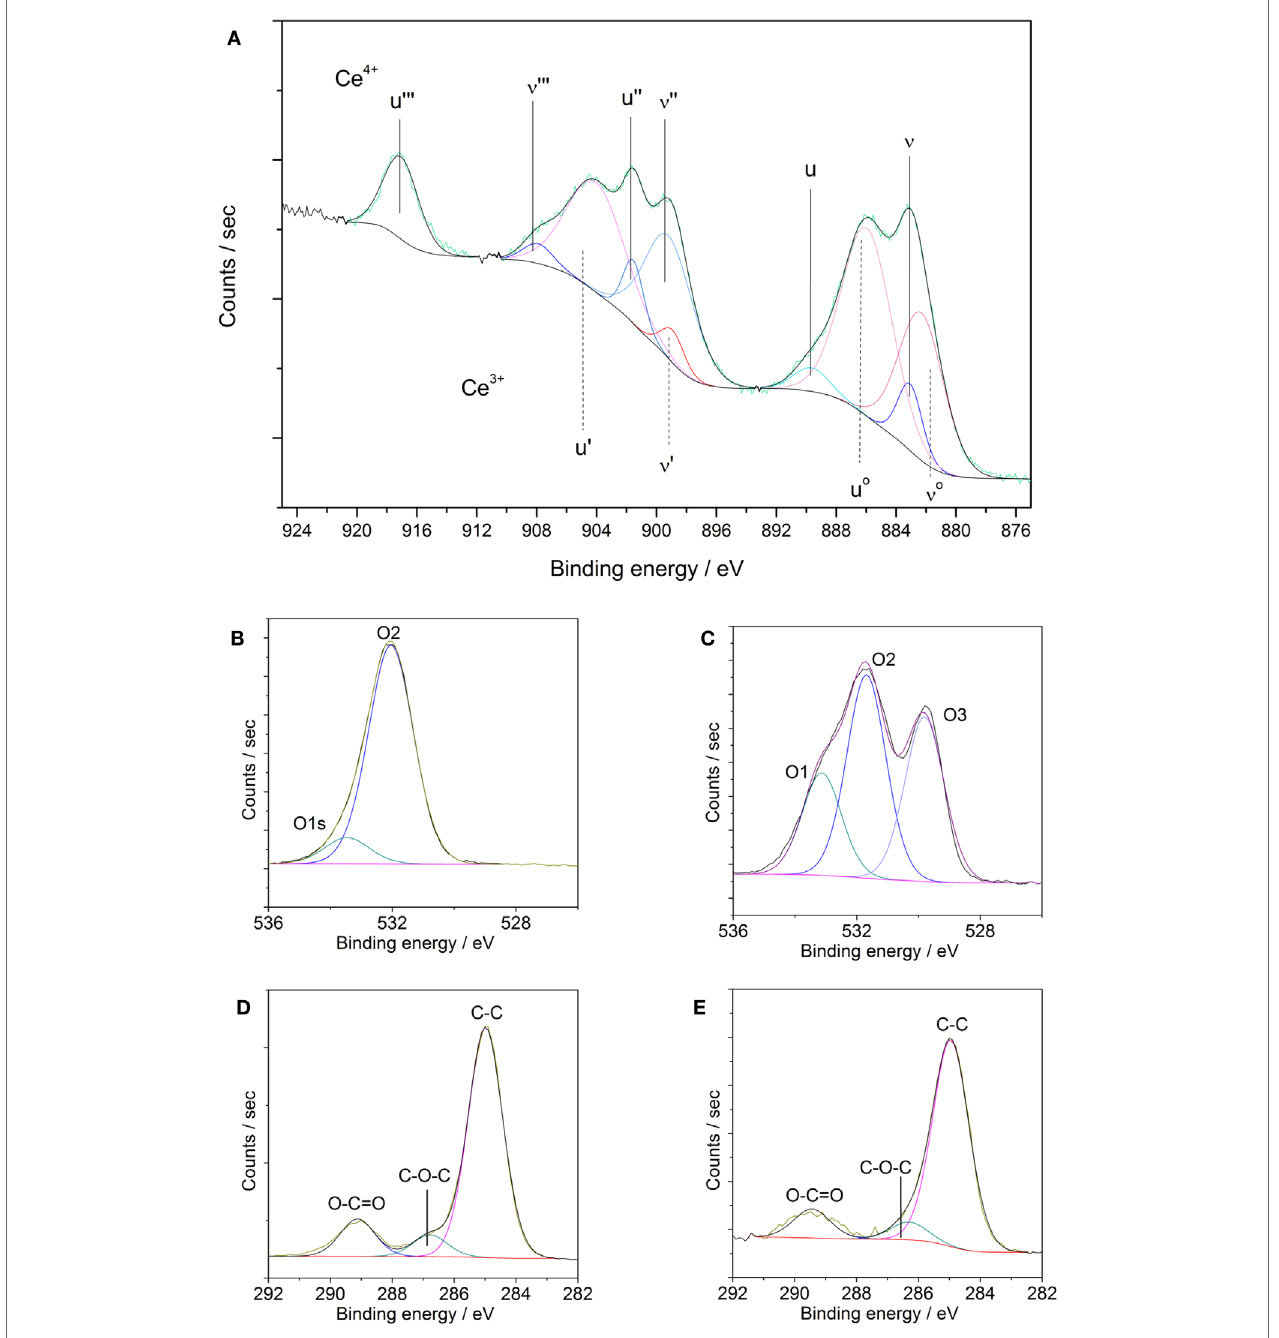
FigUre 6 | (a–e) XPS element spectra of AZ31 and US Ce oxide-coated AZ31. (a) Ce3d of coated sample; (B) O1s of AZ31; (c) O1s of coated AZ31; (D) C1s of AZ31 and (e) C1s of coated